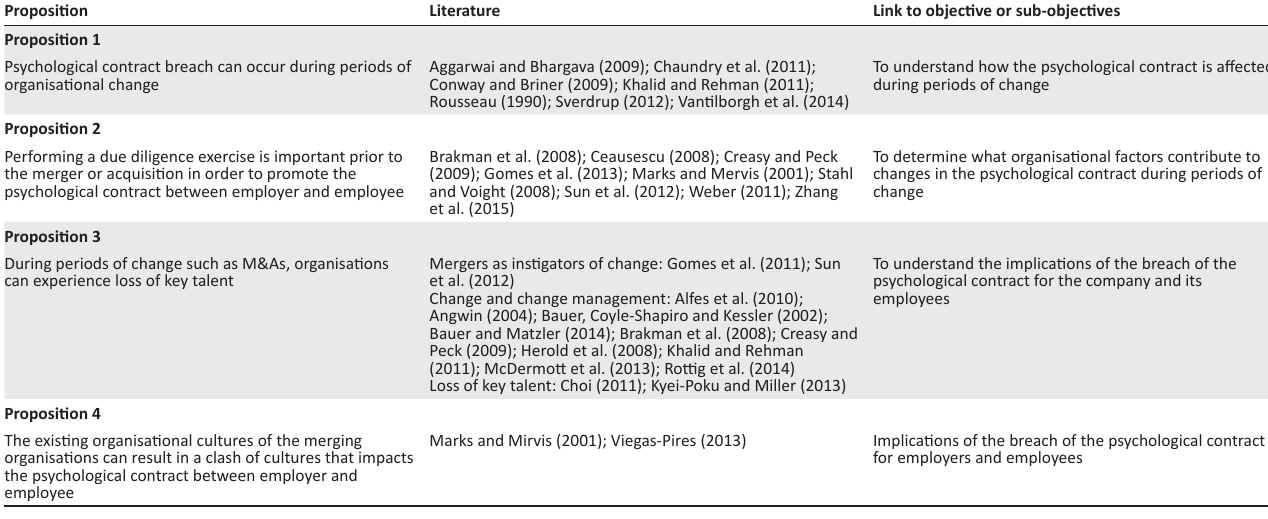
TABLE 1: Alignment propositions, literature and research objective or